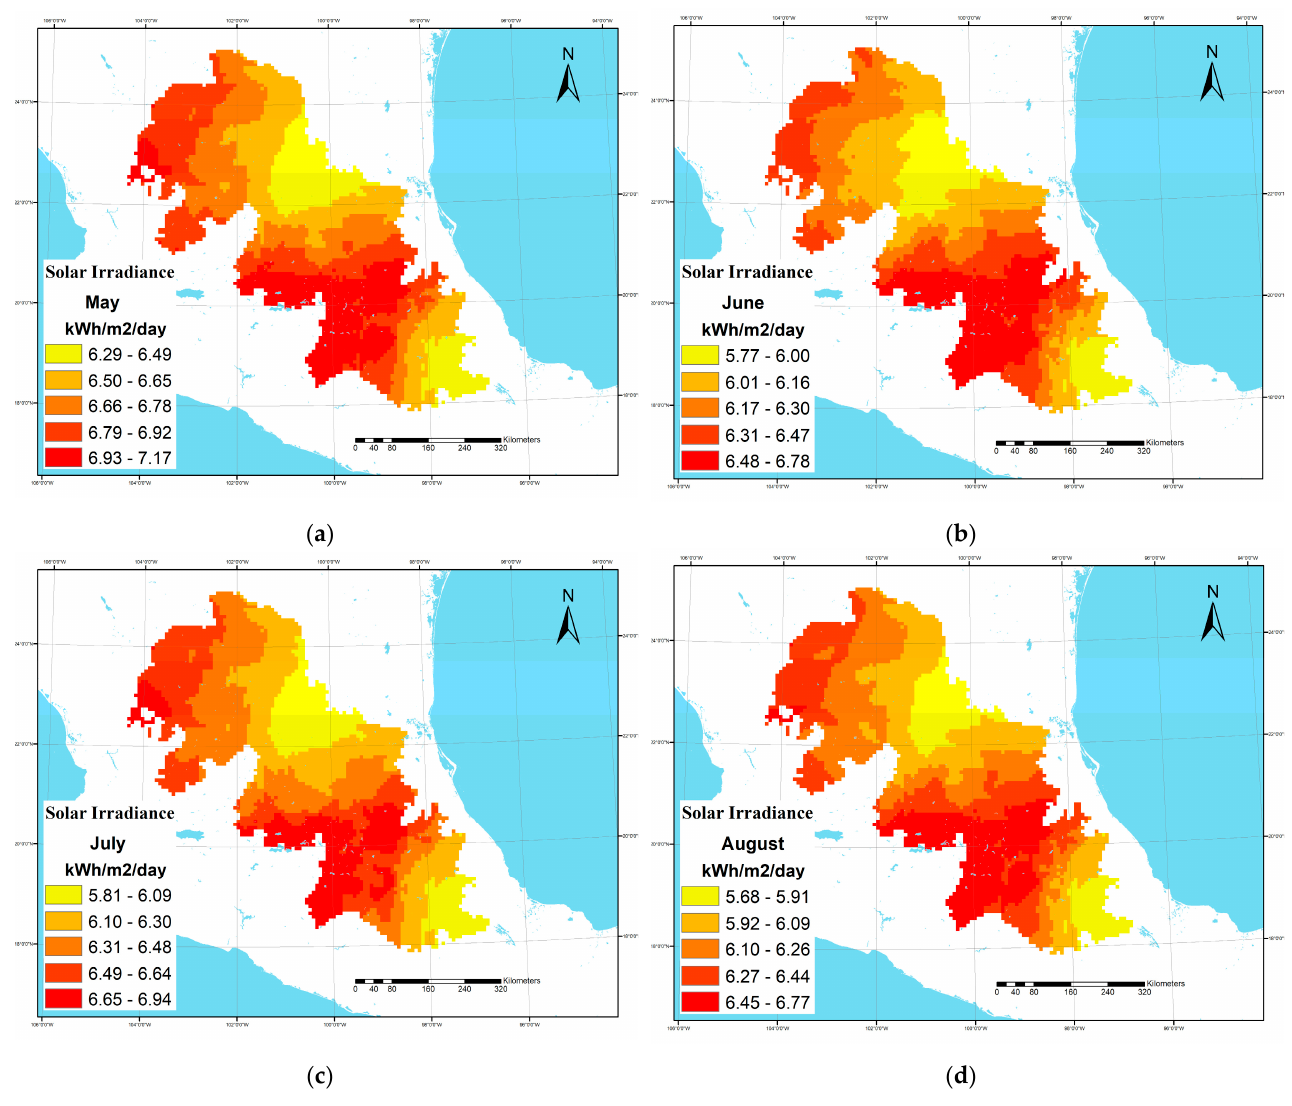
Figure 11. Average solar global irradiation in Central Mexico in ( a ) May, ( b ) June, ( c ) July, and ( d ) August.